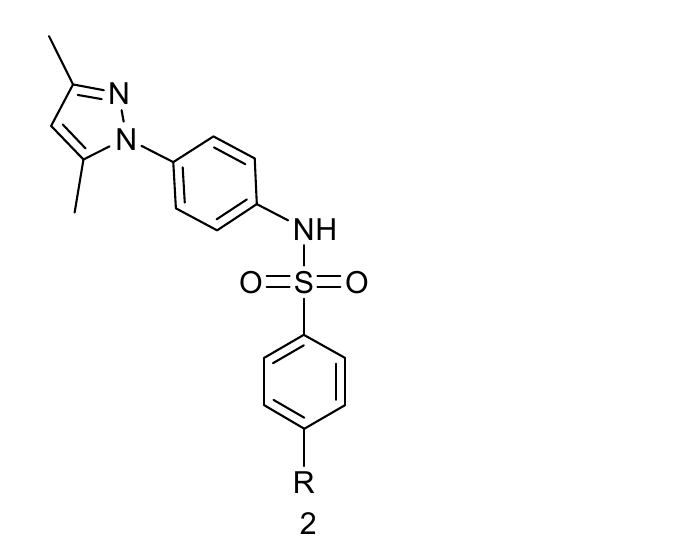
Figure 3. Structures of sulfonamides 1 and 2 prepared in this work (R = Me, NHAc; NO 2 ; NH 2 ), (R’ = 4 Cl; 4-OMe; 2,5-diOMe).